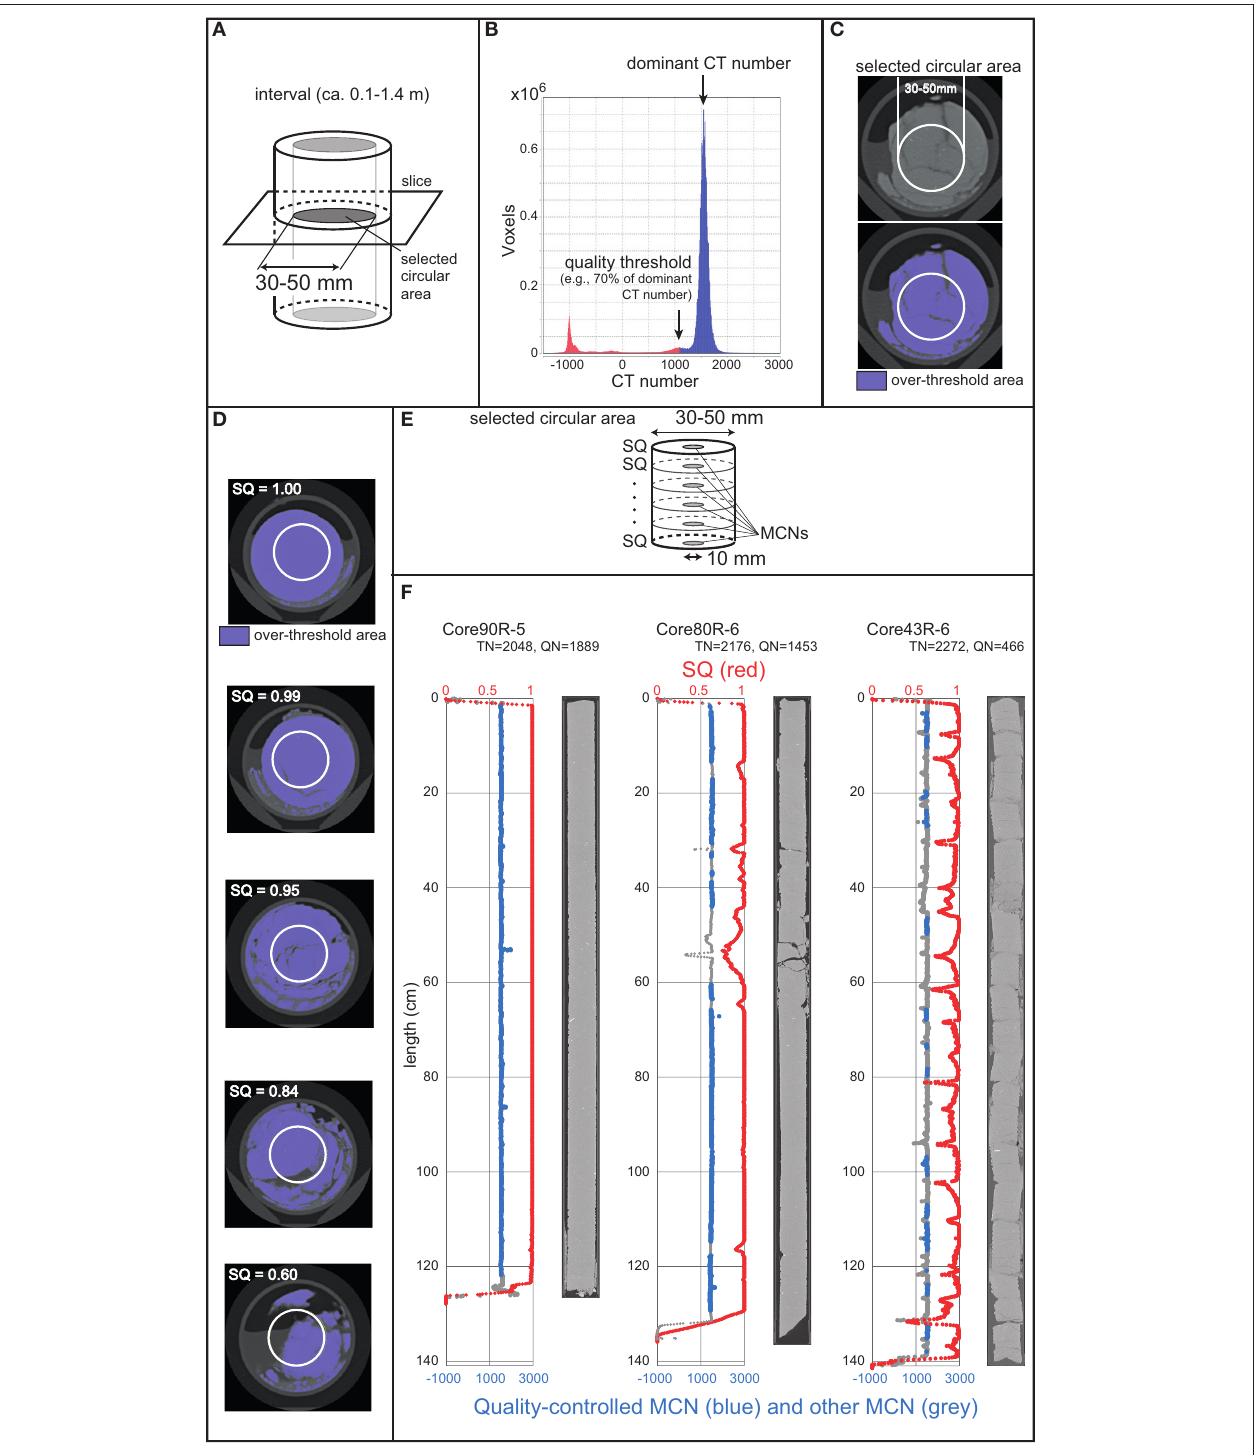
FIGURE 1 | Processing and measurement flow of slice quality (SQ) and quality-controlled mean CT number (MCN) profiles. (A) A selected circular area of a CT slice for SQ. (B) A histogram of voxel numbers against CT numbers for a selected interval. (C) Over-threshold areas of a CT slice. (D) CT slices showing different SQ. (E) Schematic image showing areas of SQ and MCNs. (F) SQs and MCNs of some typical intervals in the core samples of International Ocean Discovery Program (IODP) Expedition 370 Hole C0023A. TN, total slice number; QN, quality-controlled slice number.